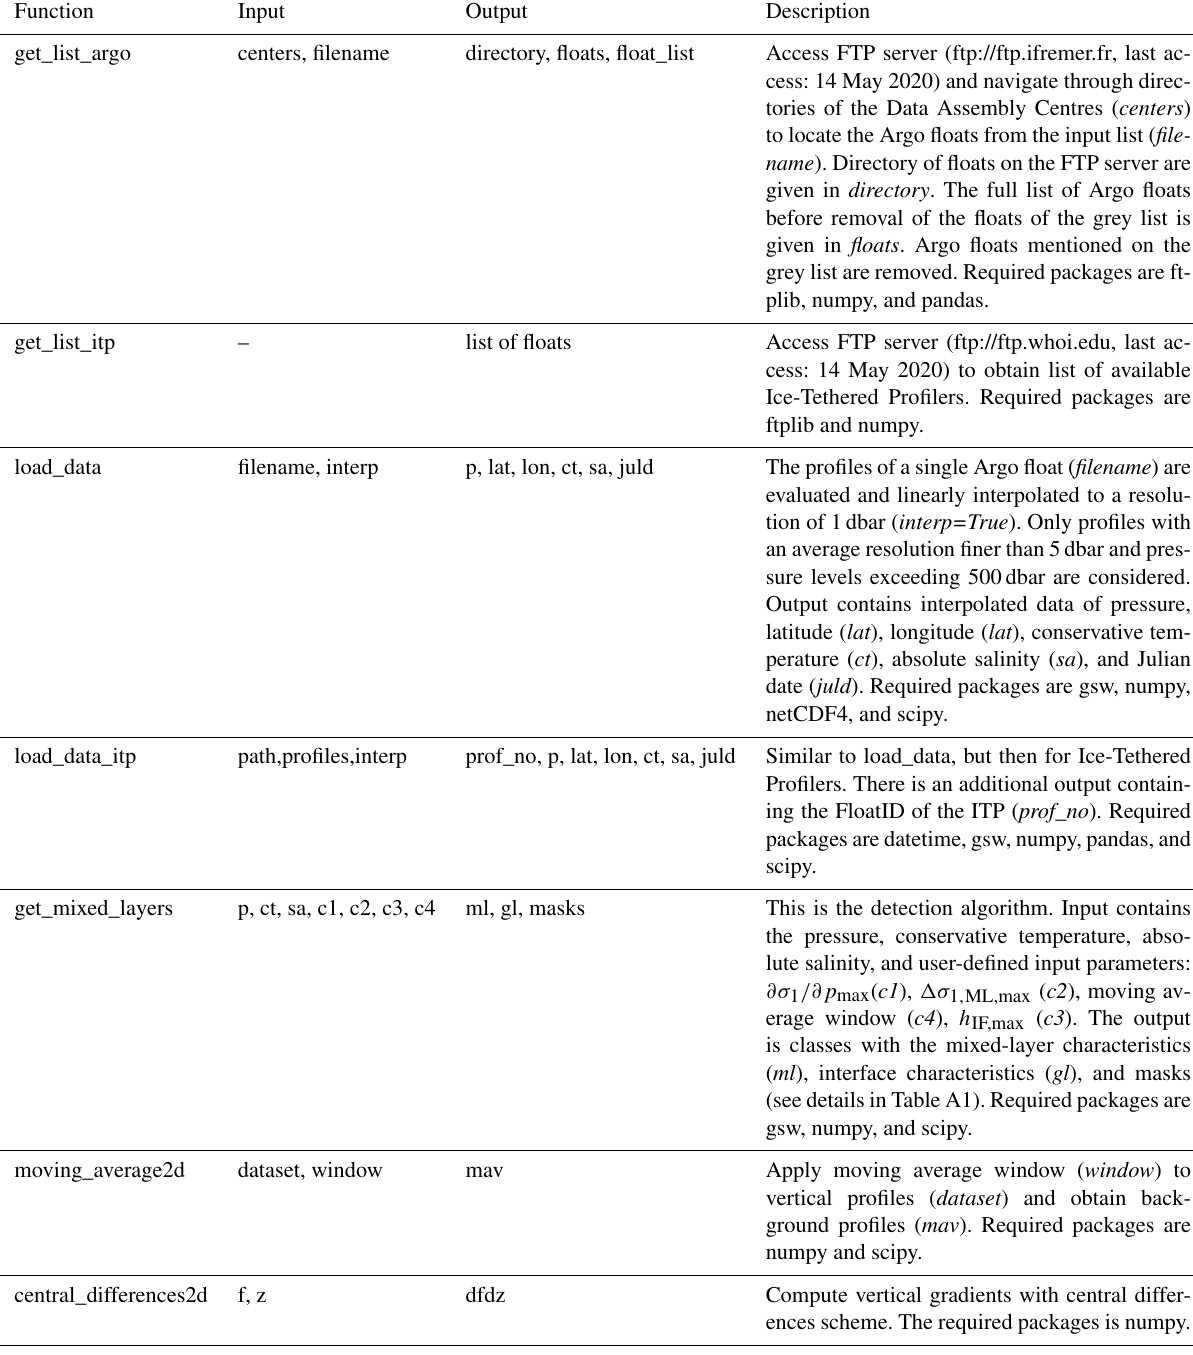
Table A2. Functions used in the software.